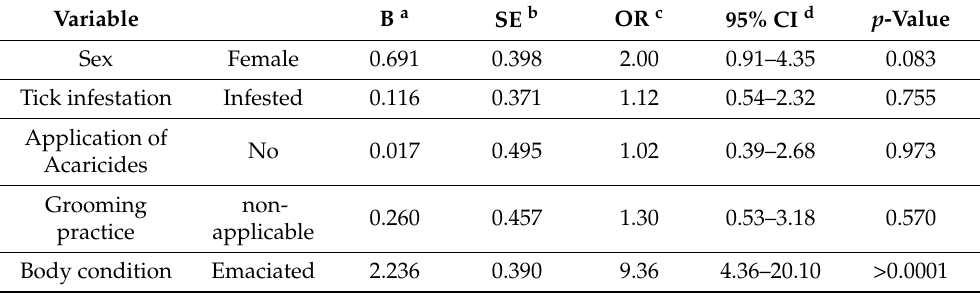
Table 2. Multivariable analysis of the potential risk variables for camel